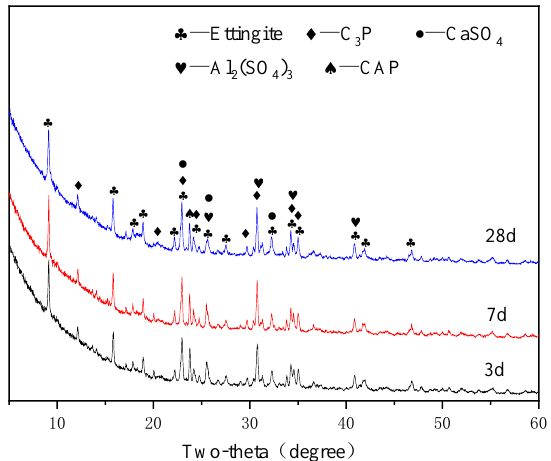
Figure 5. XRD patterns of APC paste for G0 group at different ages.